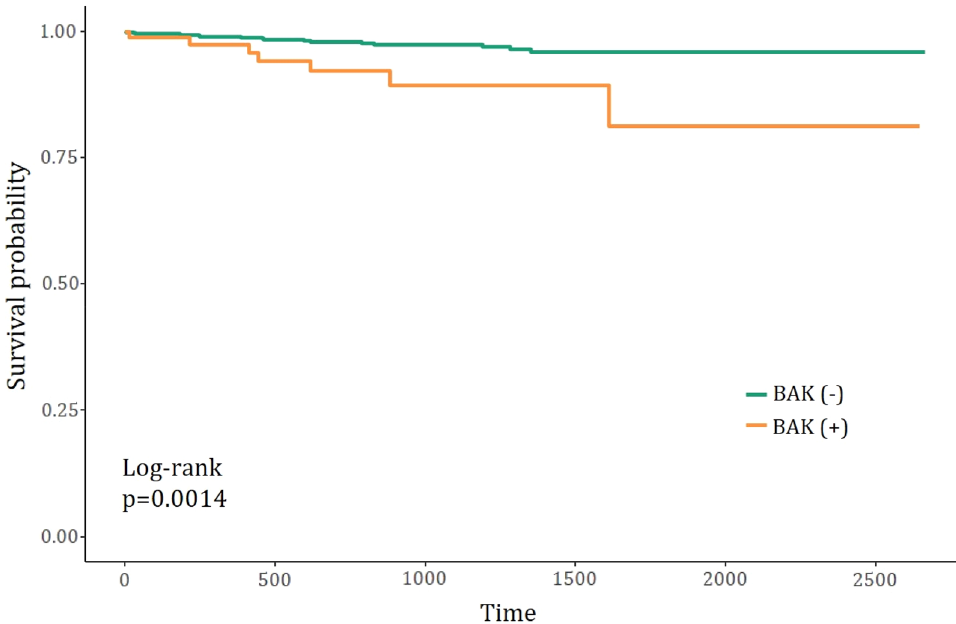
Figure 2. Kaplan-Meyer graph predicting the occurrence of periorbital dermatitis (BAK(+) vs BAK(−) groups).